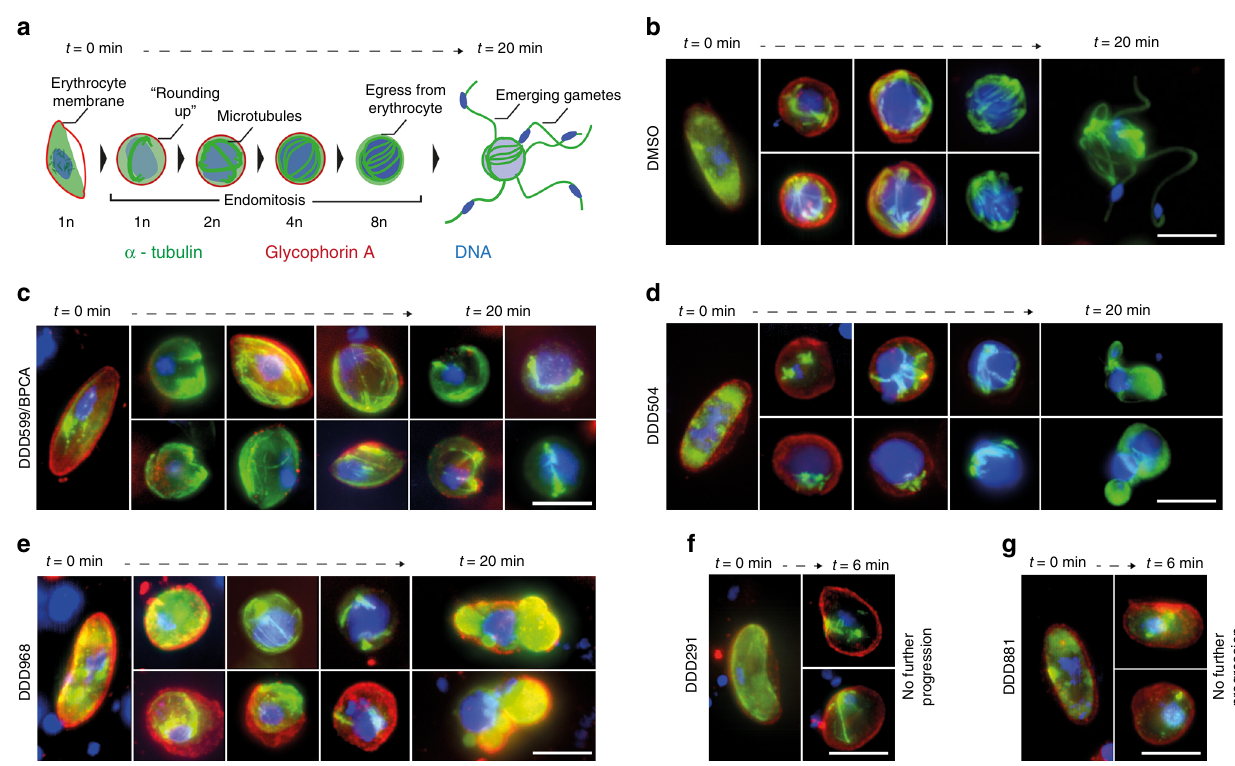
Fig. 4 Monitoring the effect of compound treatment on male gamete formation by IFA. Gametocytes were treated for 24 h with DMSO or 10 µ M test compound and then gamete formation triggered by the addition of ookinete medium and reduction to room temperature. Aliquots were sampled at different time points and immediately fi xed before being stained directly for α -tubulin (green), glycophorin A (red) and DNA via DAPI labelling (blue). Images show representative non-induced cells (0 min), representative cells during gamete formation progression (2 – 10 min), and representative cells showing the most advanced phenotype at 20 min. a Upon activation, male gametocytes initially round up before undergoing three endomitotic genome replications, egressing from the surrounding erythrocyte membrane and releasing up to eight fl agellated gametes. b Images from left to right show DMSO- treated cells undergoing normal male gamete formation over 20 min. Male gametocytes initially have an elongated morphology with a faint nucleus, relatively homogenous tubulin distribution and are surrounded by an erythrocyte membrane. Upon induction of gametogenesis, cells round up and begin three rounds of endomitosis, with ordered microtubule spindle fi bres and increasingly intense DNA staining. Towards the end of gametogenesis, the surrounding erythrocyte membrane is shed and up to eight microgametes emerge from the cell possessing a microtubule-rich fl agellum and one replicated genome. c DDD599/BPCA-treated cells; d DDD504-treated cells; e DDD968-treated cells; f DDD291-treated cells; g DDD881-treated cells. Bars = 5 µ